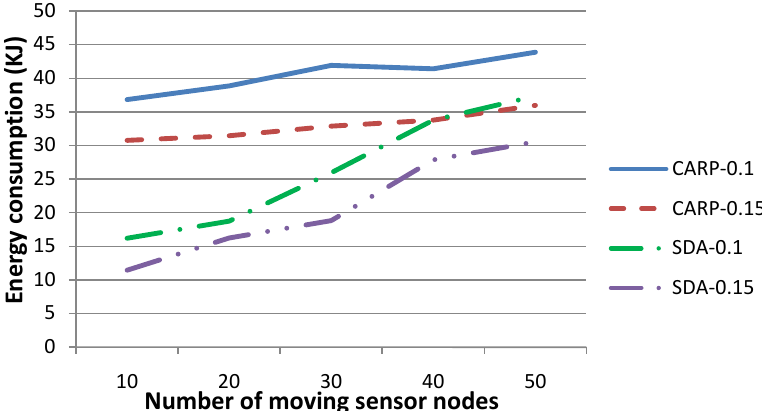
Figure 13. Comparison of energy consumption for our technique (SDA) with respect to CARP as the routing protocol, when the transmission radius r is set to 0.1 and 0.15, respectively, and the number of sensor nodes, which drift with the water dynamics and change their coordinates, is set to various values. This figure shows that the energy consumption for our gathered strategy is much smaller than that of CARP, especially when the number of moving sensor nodes is relatively